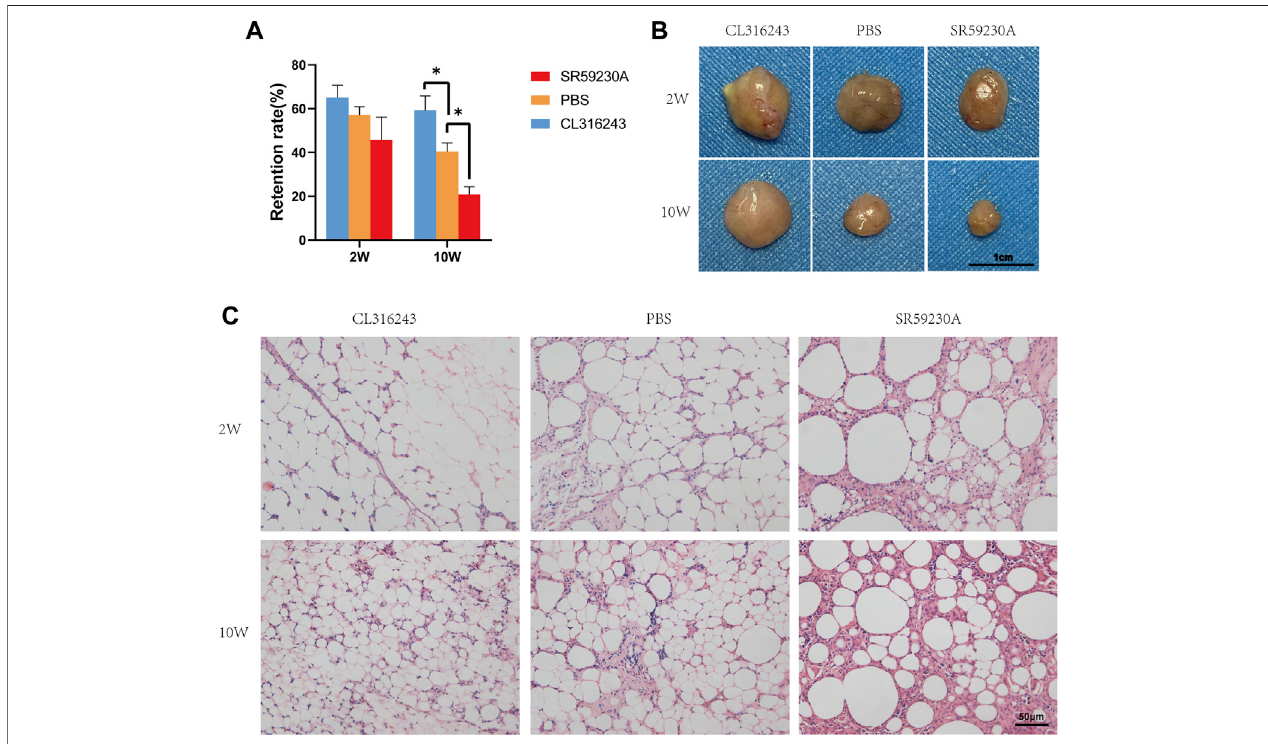
FIGURE 2 | Retention ( fi nal mass/initial mass) and adipose structure of the transplanted fat in the three groups. (A) After 2 weeks, there was no signi fi cant difference, but after 10 weeks, retention was signi fi cantly better in the browning upregulation group (CL316243) than in the control group (PBS) and the browning downregulation group (SR59230A) showed signi fi cantly poorer retention than the control group. (B) Swelling of the transplanted adipose tissue was found in the upregulation group but not in the control group and downregulation group at week 2; however, the grafts in the downregulation and control groups obviously shrank at week 10. (C) Histologic analysis showed that fat grafts from the control group had normal adipose structure 10 weeks after transplantation, whereas samples from CL316243-treated mice had superior structure. However, grafts from the browning upregulation group demonstrated small, brown-like adipocyte features, whereas grafts from the browning downregulation group contained more oil cysts, larger adipocytes, and crown-like structures. (* p < 0.05)